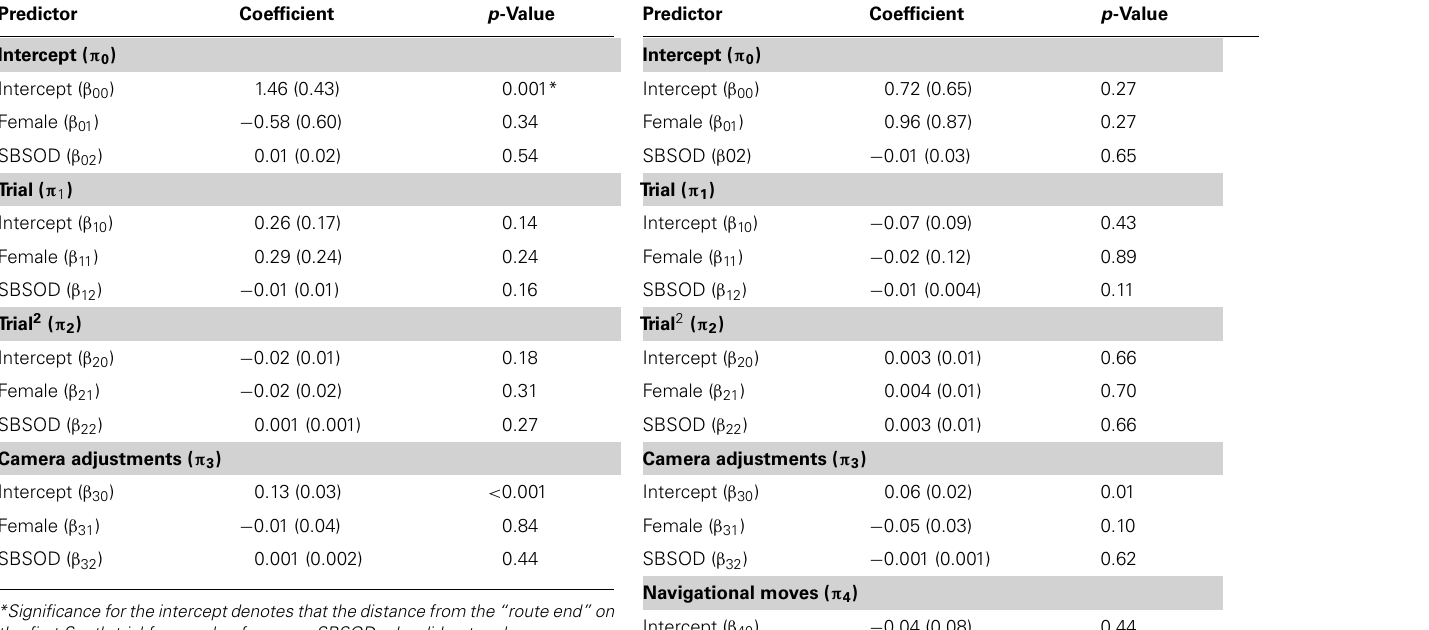
Table 5 | Regression coefficients for distance to target location on Uninformative Landmark trials.